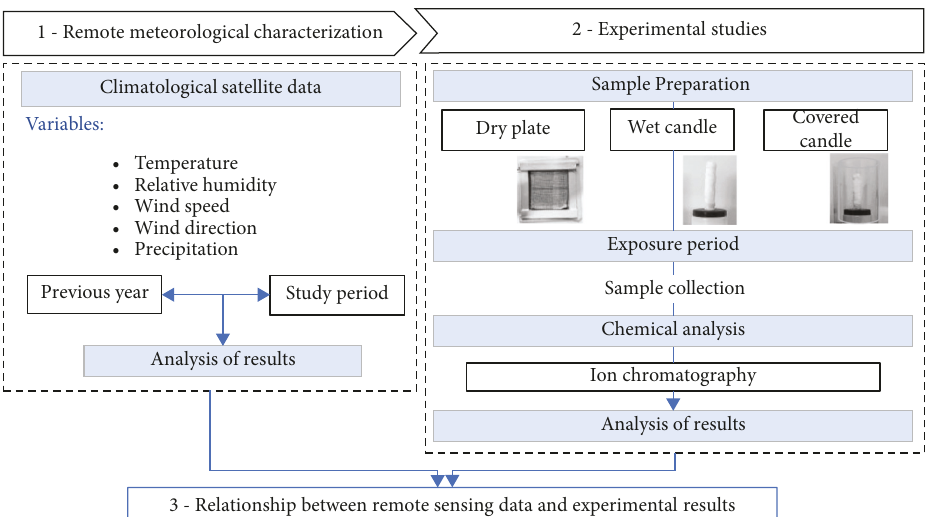
Figure 1: Outline of the common methodology for all tests.